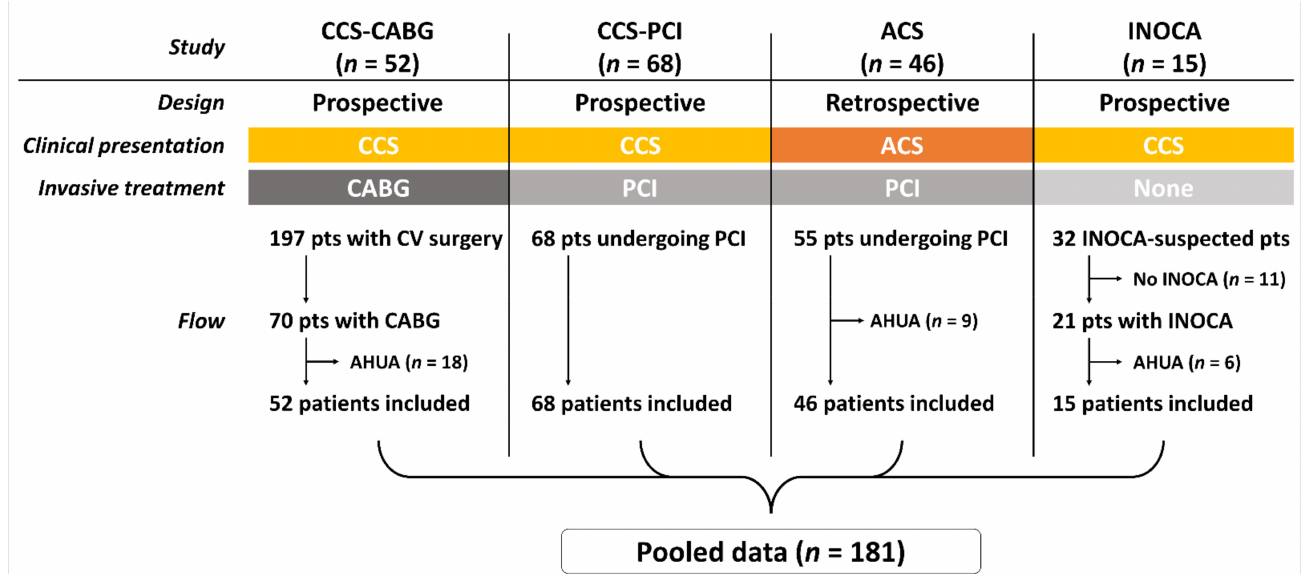
Figure 1. Study flow. ACS: acute coronary syndrome, AHUA: antihyperuricemic agent, CABG: coronary artery bypass grafting, CCS: chronic coronary syndrome, INOCA: ischemia with no obstructive coronary artery disease, PCI: percutaneous coronary